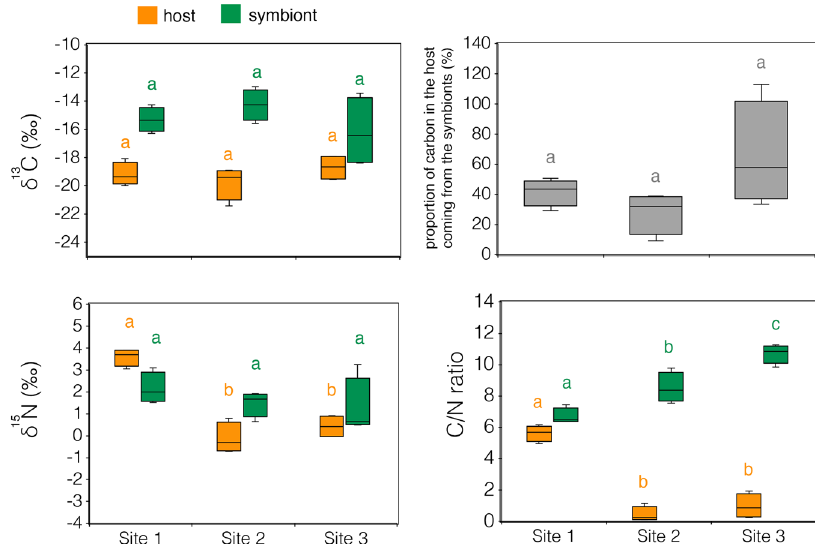
Fig. 4 δ 13 C, δ 15 N, C/N ratios, and proportion of carbon in the host coming from the symbionts in B. europaea tissue from Sites 1 (control), 2 (intermediate pH) and 3 (low pH). The proportion of carbon in the host supplied by the symbionts was calculated using the formula: δ 13 C tissue ¼ ð δ 13 C Þ x þ ð 1 (cid:2) x Þð δ 13 C Þ . We assume δ 13 C = − 22 ‰ 37 . The boxes indicate the 25 th and 75 th percentiles and the line within zooplankton/POC symbiont zooplankton = POC the boxes mark the medians. Whisker length is equal to 1.5 × interquartile range (IQR). Different letters indicate statistical differences ( p < 0.05) between Sites (number of corals = 4 per